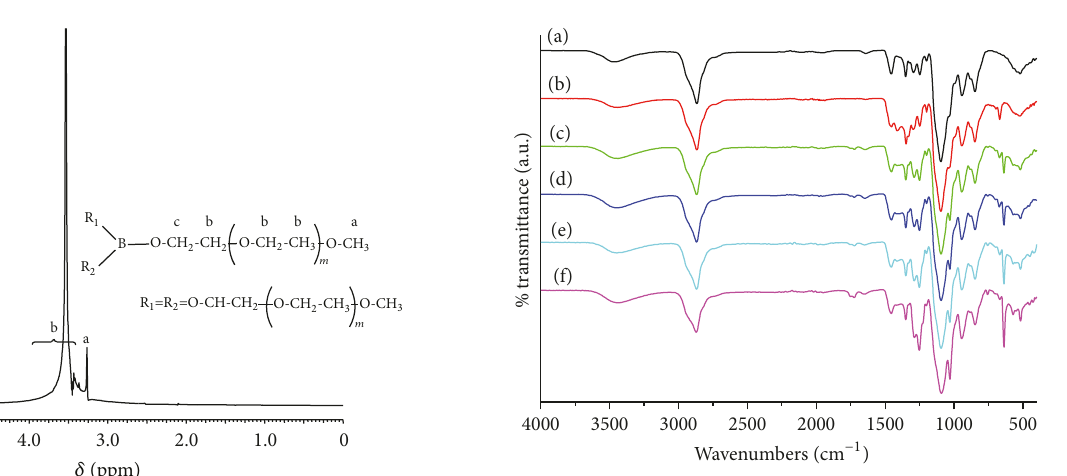
Figure 2: 1 H NMR spectra of PEGME coordinated boron.